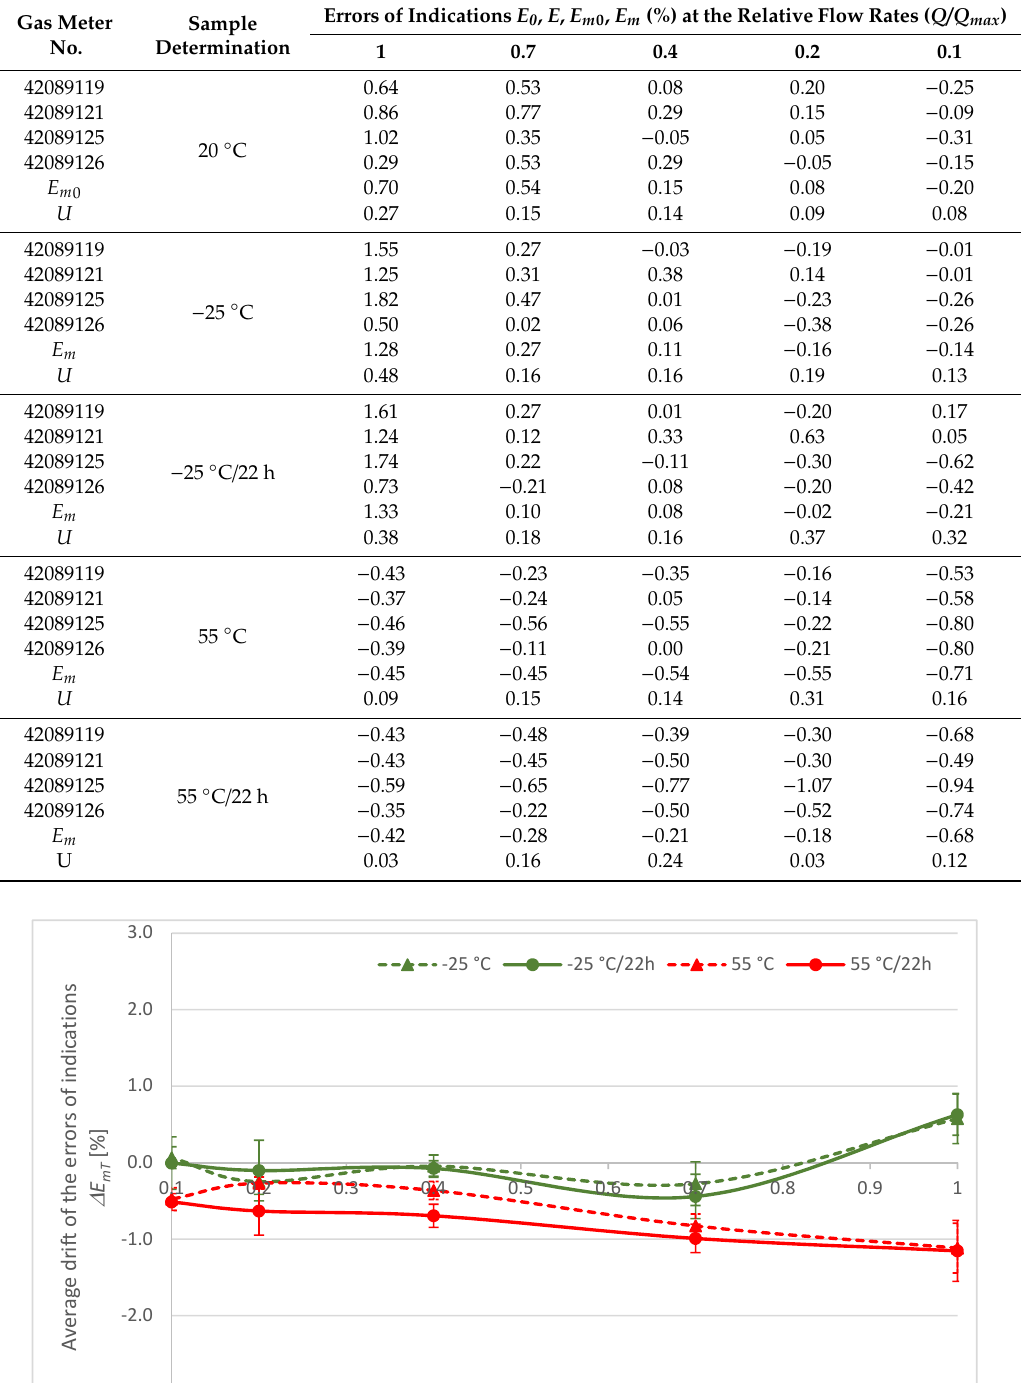
Table 4. The errors of indications ( E 0 , E ) and average errors of indications ( E m 0 , E m ), along with the confidence interval ( u ) of thermal gas meters at ambient and gas temperatures of − 25 ◦ C and 55 ◦ C, respectively, at relative flow rates ( Q / Q max ).